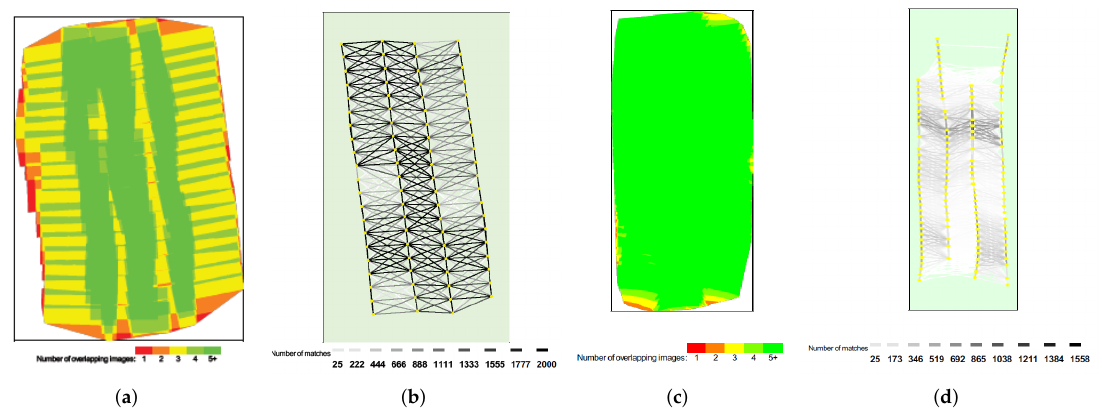
Figure 7. Overlap and field of view ( a ) plot quantifying the overlap of the RGB data, image overlap is highest along the three flight lines; ( b ) trade-off between overlap and resolution; the narrower field of view of the Nikon enables it to record at a higher resolution, thereby identifying more features and more tie points being automatically detected; ( c ) overlap for the multispectral sensor; a wider field of view and flight lines designed for the Nikon have resulted in massive overlap across the survey area providing useful redundancy; ( d ) the wide field of view of the multispectral camera results in a lower spatial resolution and accordingly fewer tie